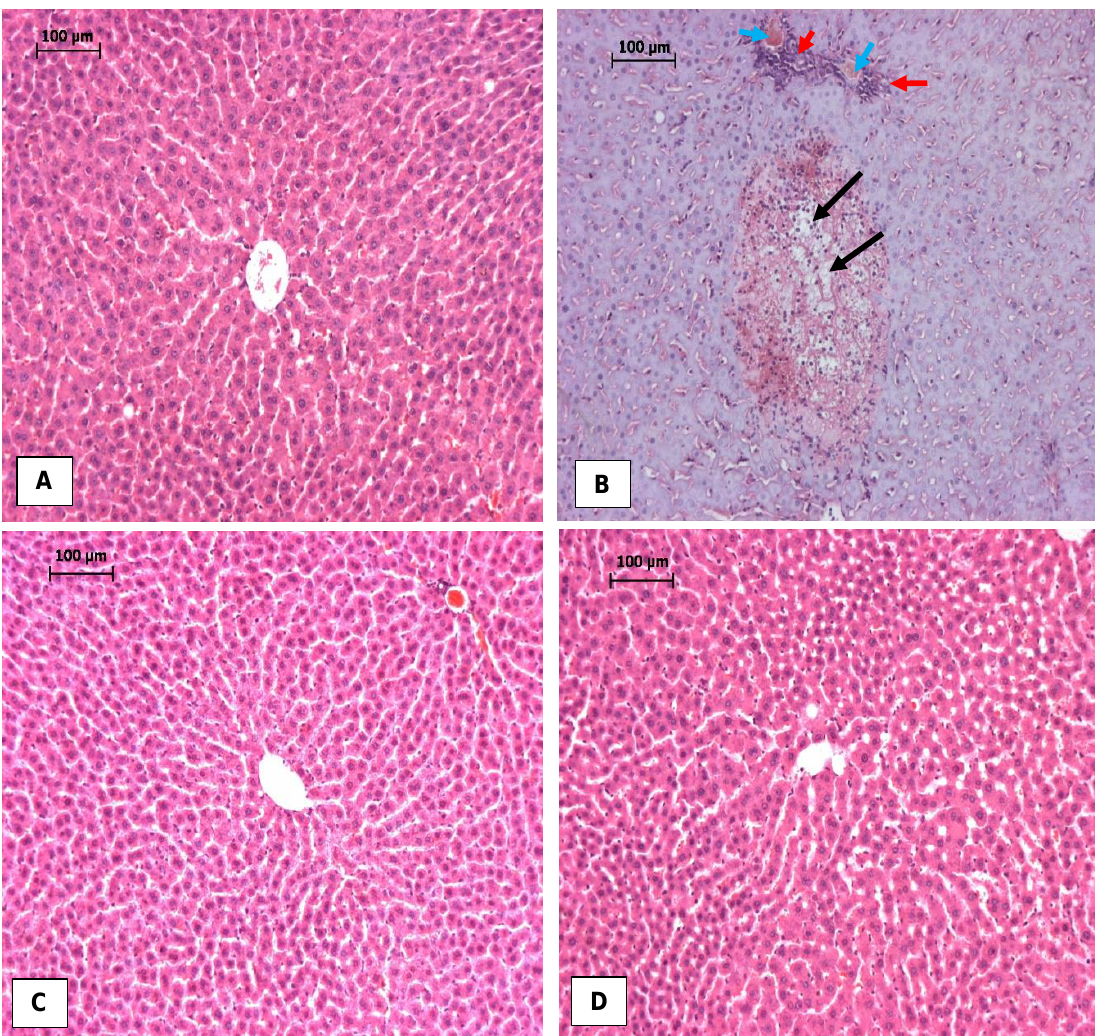
Figure 3 . Photomicrograph of liver sections of (A) normal control rats showing normal liver architecture, Figure 3. Photomicrograph of liver sections of ( A ) normal control rats showing normal liver archi- (B) LPS-induced rats showing large section of degenerative and necrotic changes (black arrows), tecture, ( B ) LPS-induced rats showing a large section of degenerative and necrotic changes (black leukocytes infiltration (red arrows) and hemorrhage (blue arrows), (C) RPO treated rats with normal liver arrows), leukocytes infiltration (red arrows) and hemorrhage (blue arrows), ( C ) RPO-treated rats with architecture and (D) LPS-induced rats pre-treated with RPO showing almost normal liver architecture. normal liver architecture and ( D ) LPS-induced rats pre-treated with RPO showing almost normal (Hematoxylin and Eosin (H&E); 10X). liver architecture. (Hematoxylin and Eosin (H&E); 100 ×